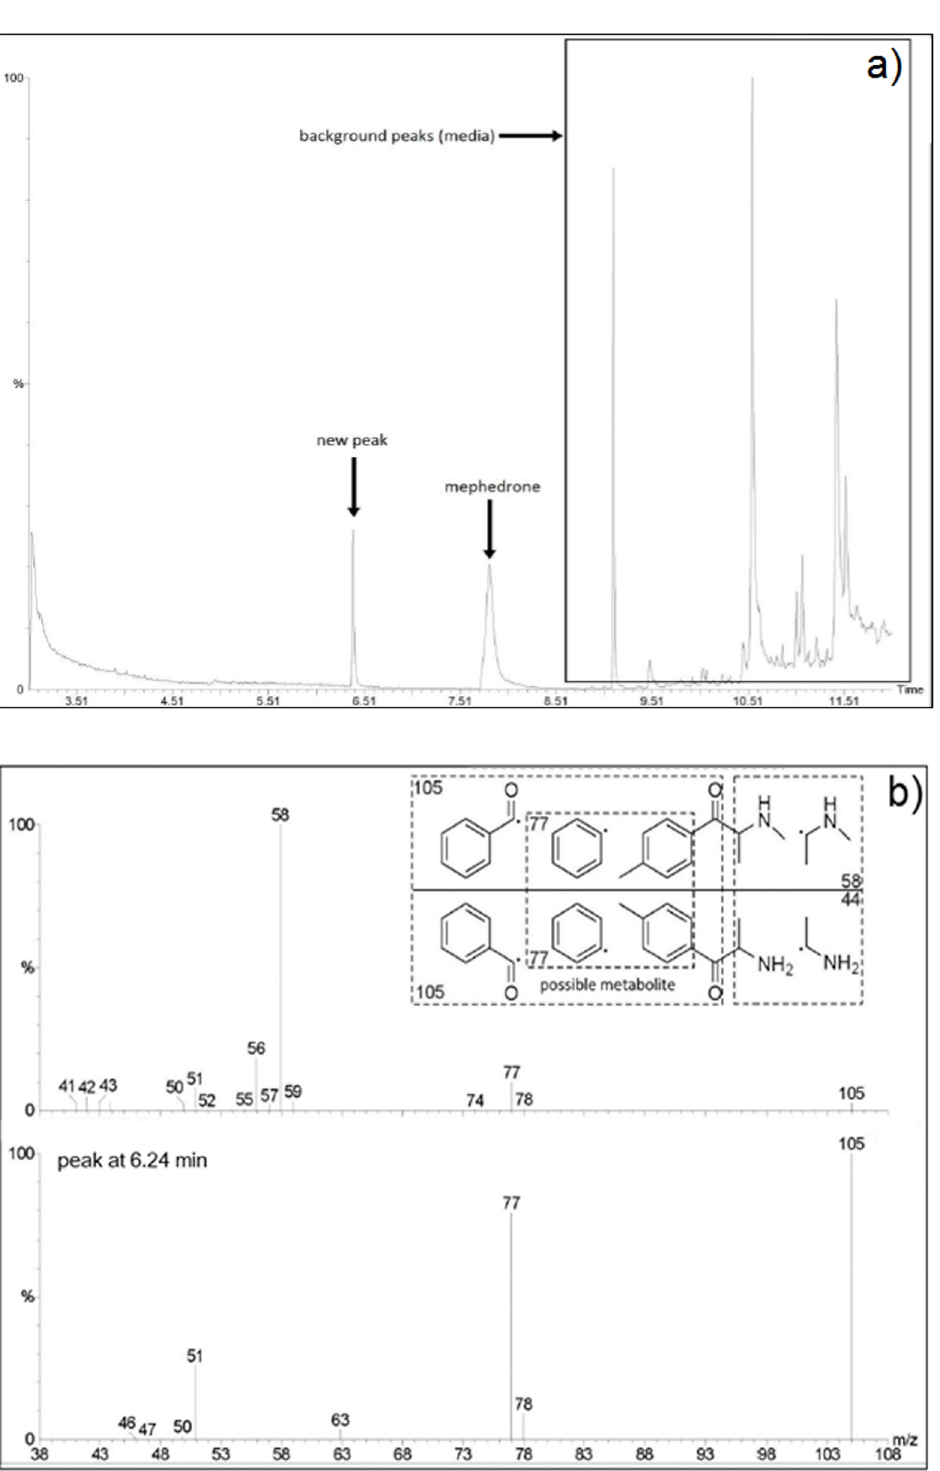
Figure 5: Sample chromatogram ( a ) and mass spectra ( b ) peak appearing at 6.24 min from samples of mephedrone after incubation with HepaRG ™ compared to